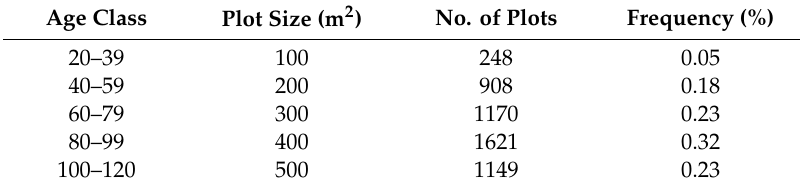
Table 1. Frequency of temporary sample plots (TSP) of di ff erent size in age classes. Age Class Plot Size (m 2 ) No. of Plots Frequency (%) 20–39 100 248